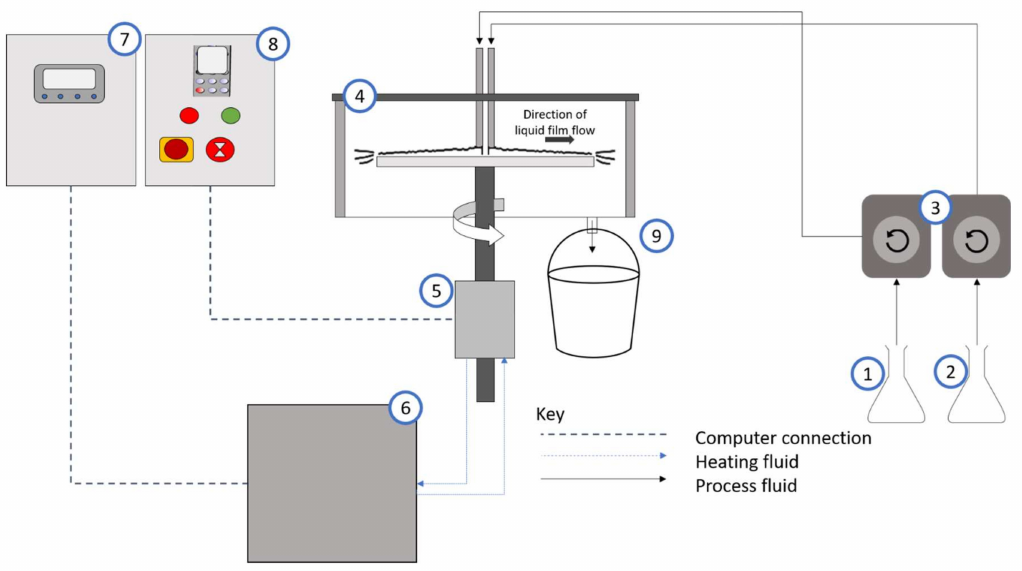
Figure 2. Schematic of spinning disc reactor (SDR) set-up: ( 1 ) Solute / solvent; ( 2 ); antisolvent; ( 3 ) peristaltic pumps; ( 4 ) SDR; ( 5 ) motor; ( 6 ) heating tank; ( 7 ) temperature control unit; ( 8 ) SDR rotational control unit; ( 9 ) product outlet and